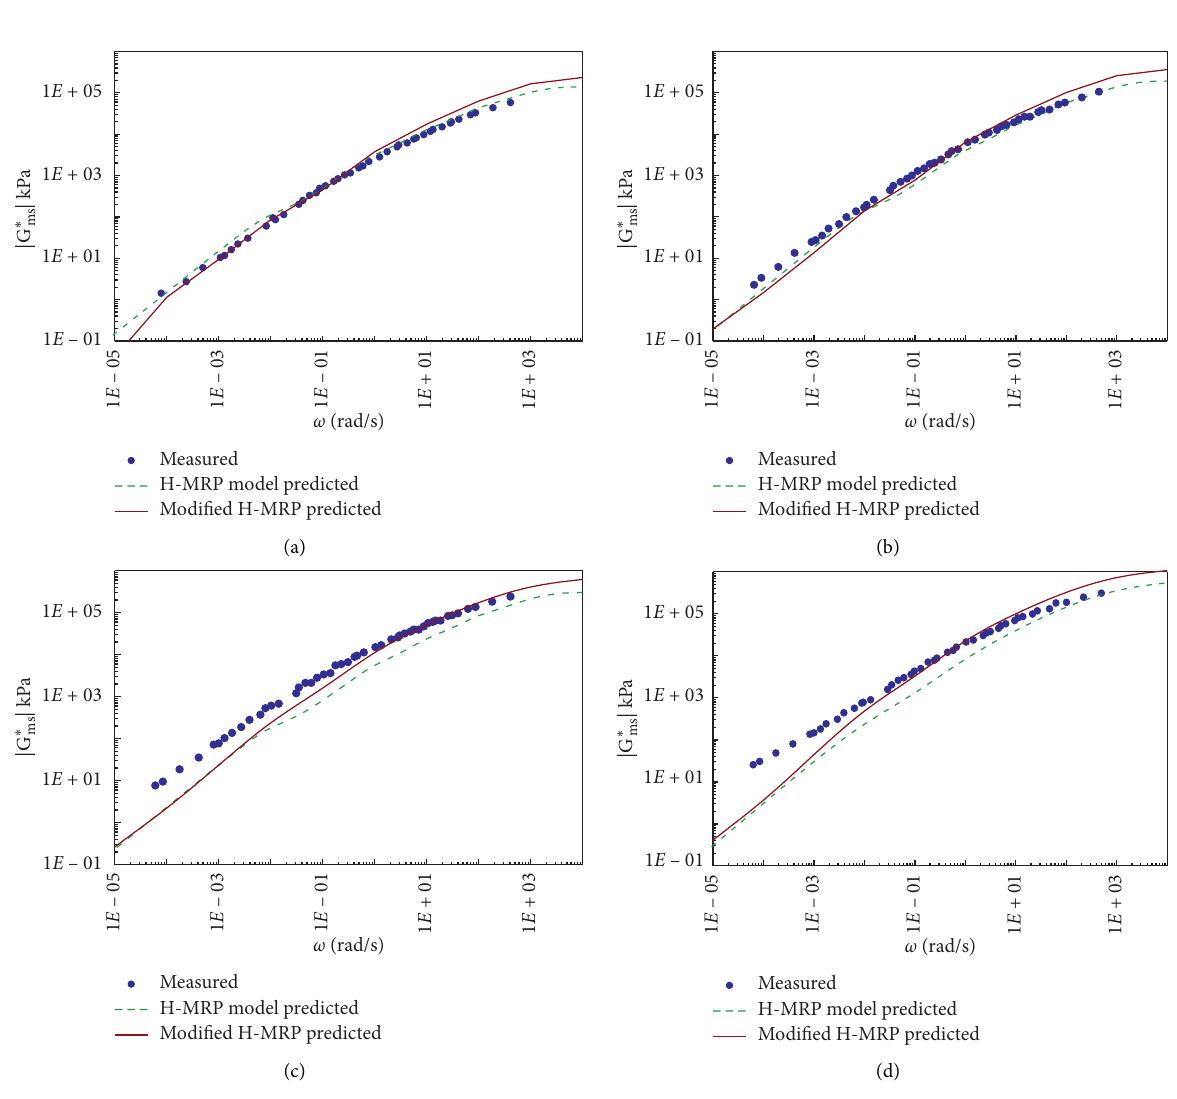
Figure 7: Comparison of predicted and measured | G ∗